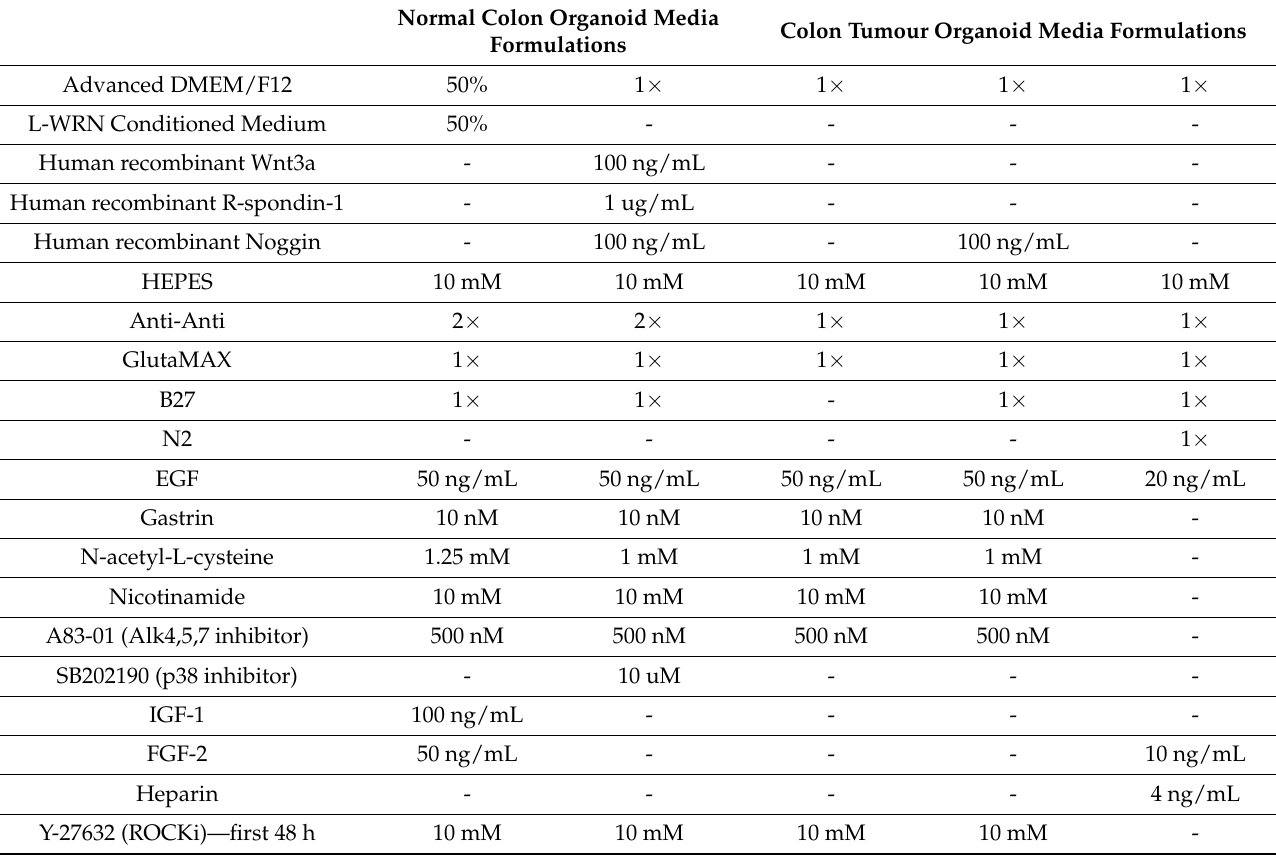
Table 1. Media formulations for culture of normal colon organoids and colon tumour